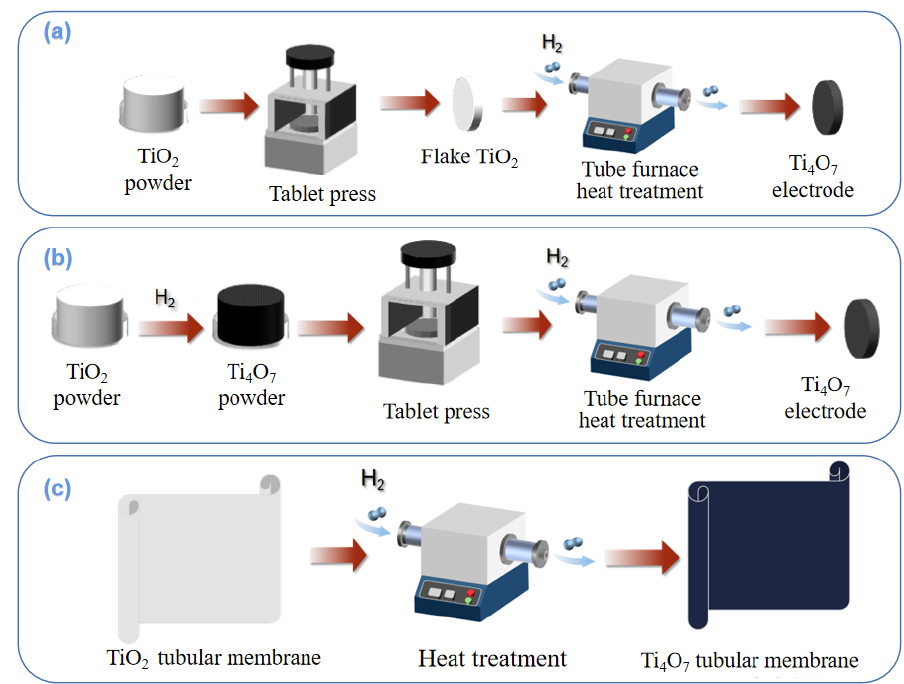
Figure 4. Preparation processes of compression reduction method ( a ); powder sintering method ( b ); membrane preparation by hydrothermal reduction method ( c ).